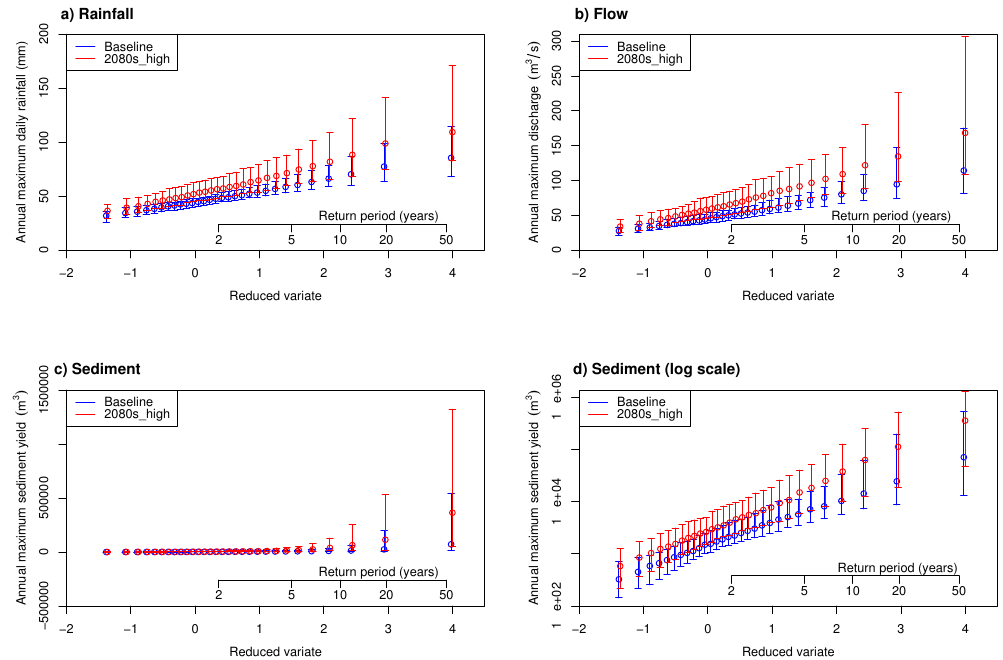
Fig. 8. Gumbel reduced variate plot of (a) annual maximum daily rainfall (mm), (b) annual maximum discharge (m 3 s − 1 ), (c) annual maximum sediment yield (m 3 ), (d) annual maximum sediment yield (m 3 ) on a log scale. For each of the 30-yr runs, for the baseline (blue) and High emissions 2070–2099 scenario (red), the median annual maximum event is plotted as a circle with the error bars showing the 5th and 95th percentiles from the 100 simulations. Return periods are shown on the